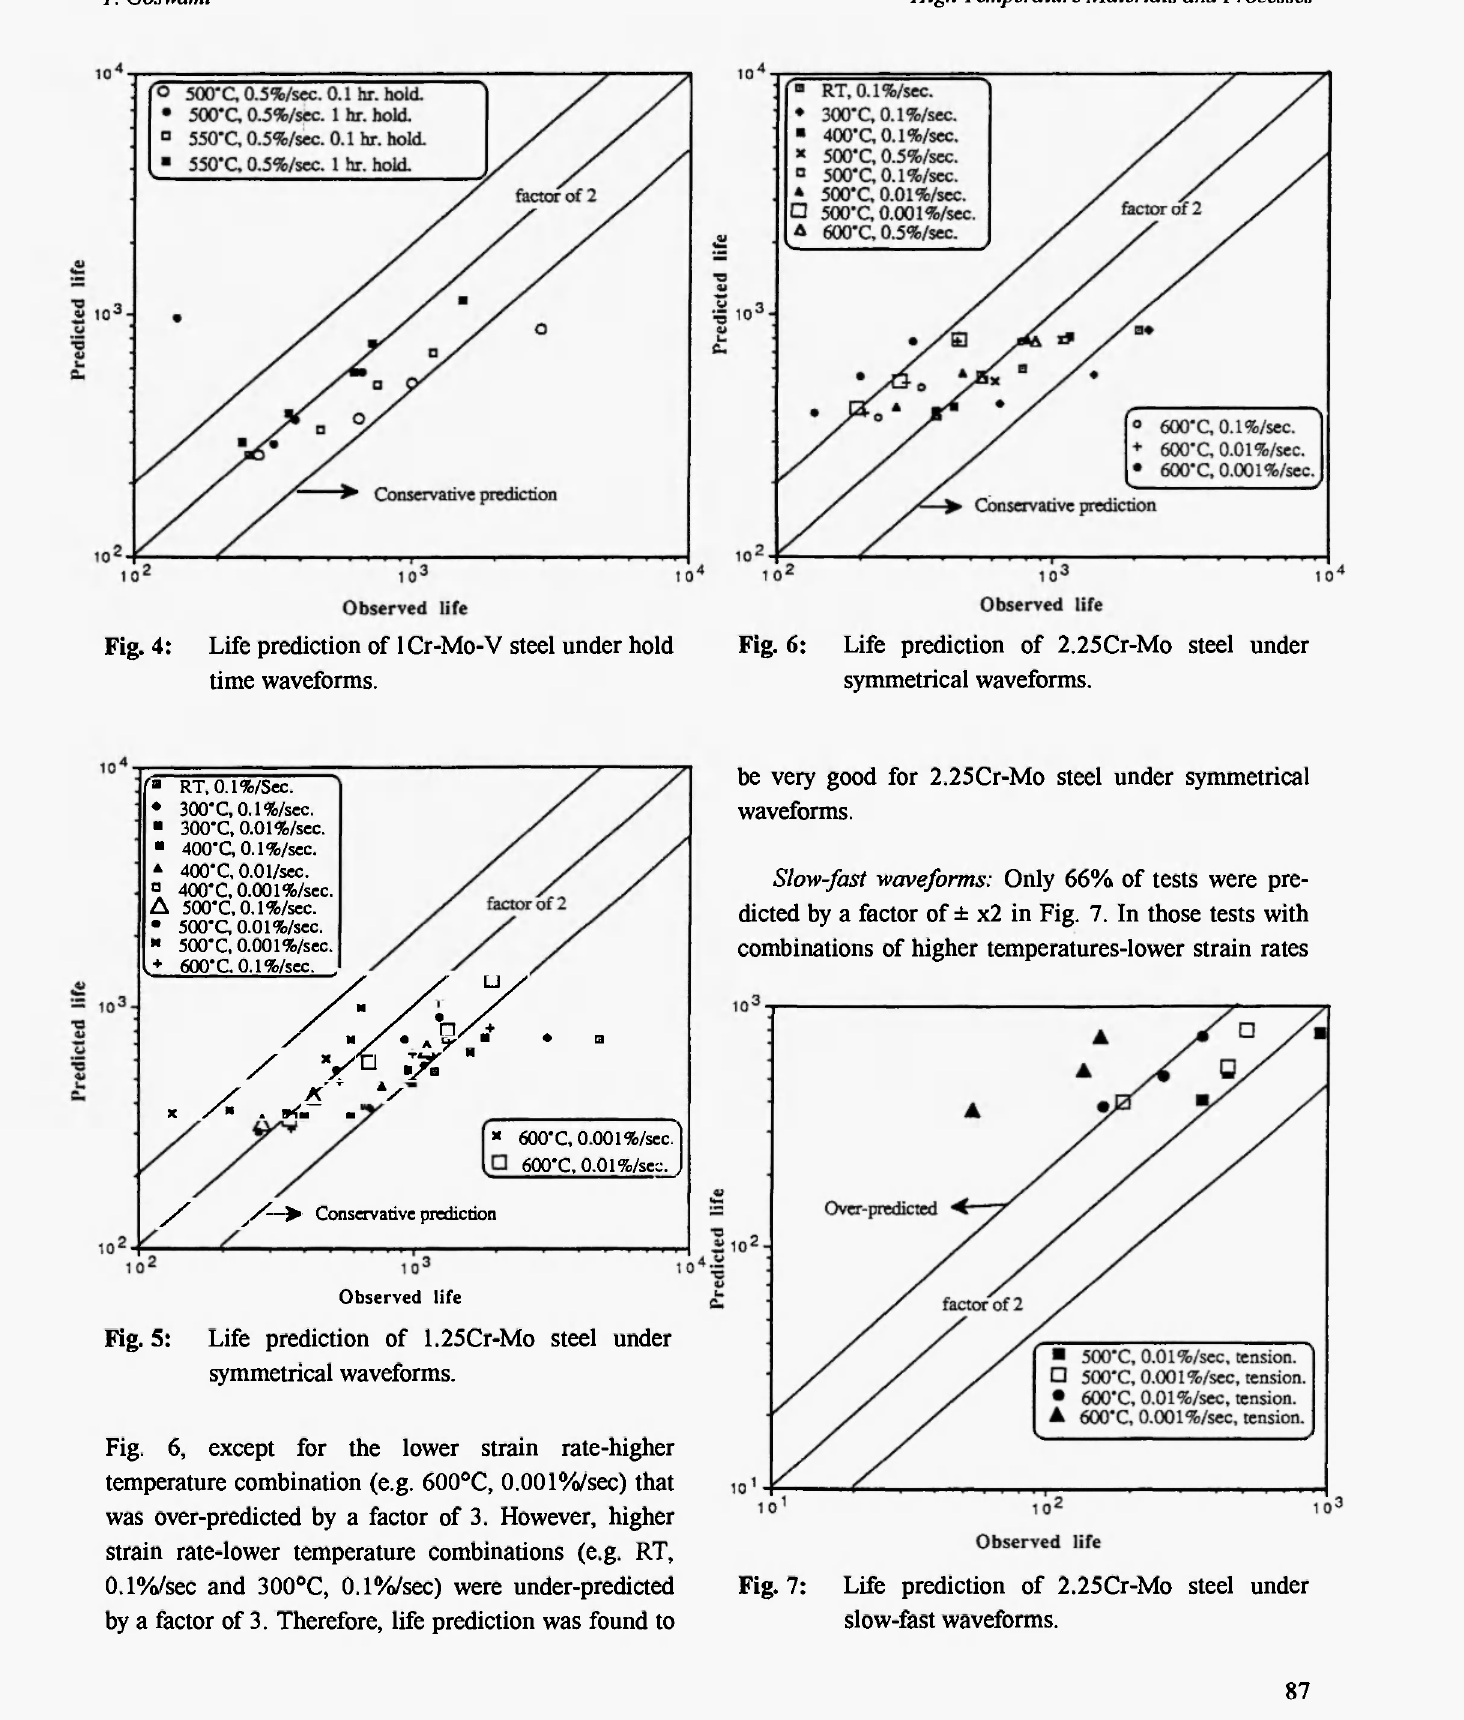
Fig. 7: Life prediction of 2.25Cr-Mo steel under slow-fast